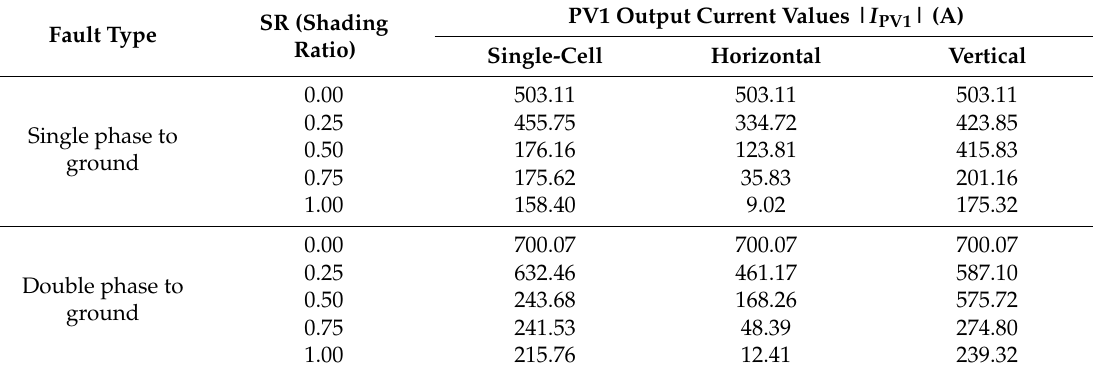
Table 2. PV1 output current values of partial shading.